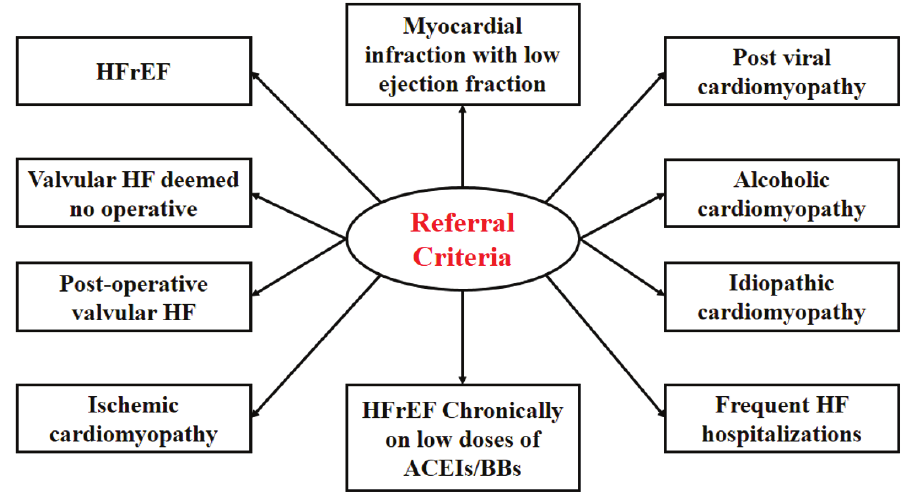
Figure 2 : Role of each specialty in multidisciplinary heart failure